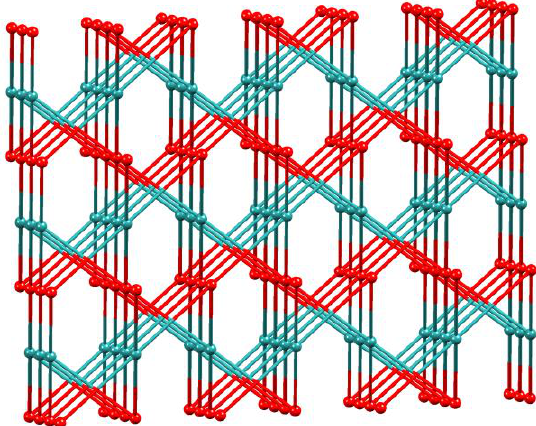
Figure 5. Topological representation of the 3D net in {[Co(NCS) 2 ( 4 )]·1.6H 2 O·1.2C 6 H 4 Cl 2 } n generated using Mercury [34,35] with 4-connecting cobalt and ligand nodes. The net in {[Co(NCS) 2 ( 3 )]·0.8C 6 H 4 Cl 2 } n is the same (see Figure S12). play a critical role in the assembly process and are not involved in π-stacking interactions. This is in contrast to the 3-phenylpropoxy groups in [Zn 2 Br 4 ( 1c ) . H 2 O] n (see introduction) [25]. Instead, the 1,2- dichlorobenzene solvate in {[Co(NCS) 2 ( 4 )]·1.6H 2 O·1.2C 6 H 4 Cl 2 } n engages in a face-to-face π-interaction with the pyridine ring containing atom N3 (Figure S13). Pertinent parameters are centroid…centroid